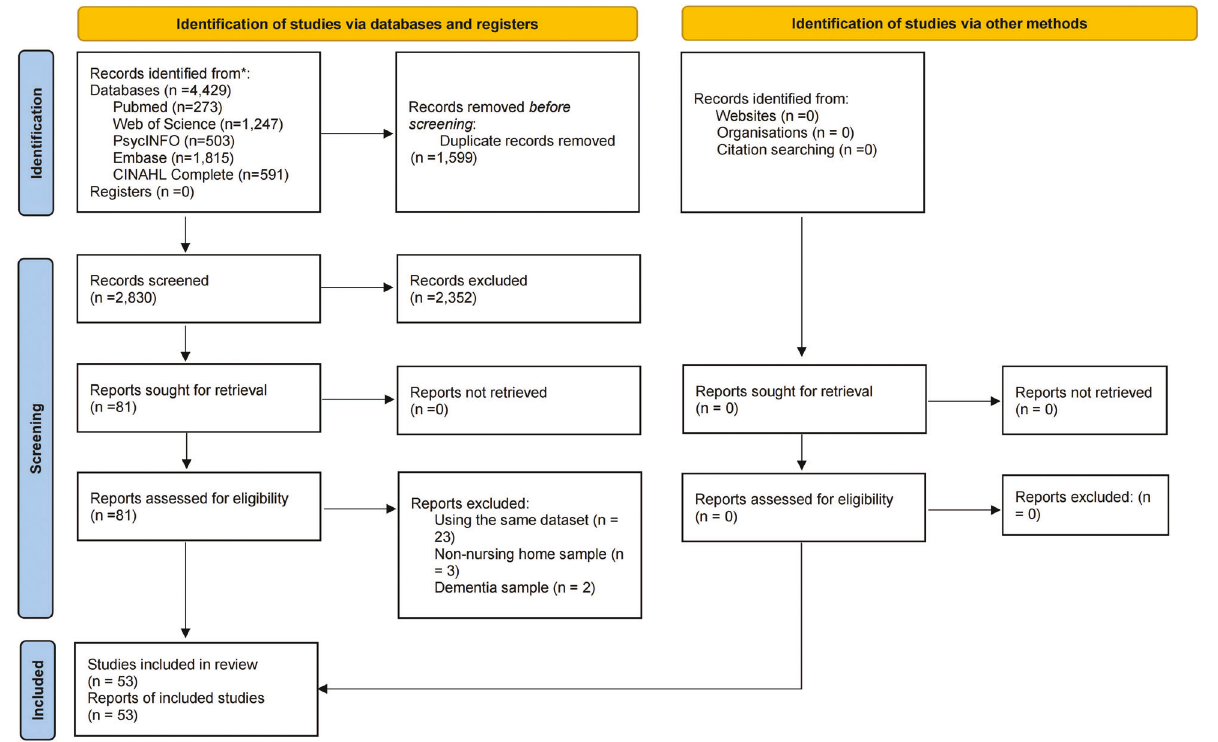
Fig. 1 Flow chart of study